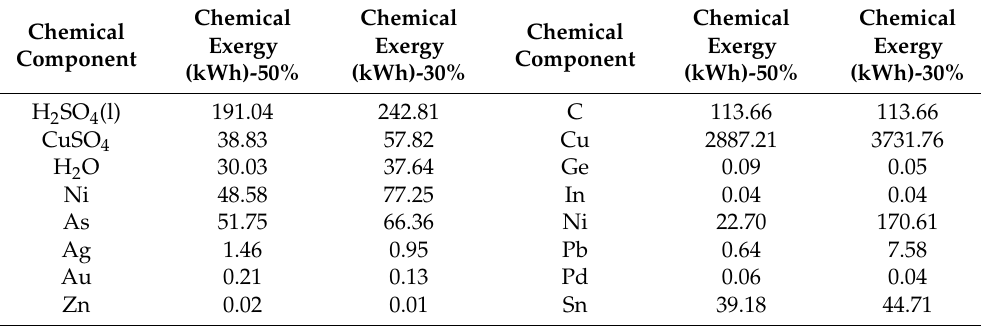
Table 8. Exergy values of materials going into the electrorefining